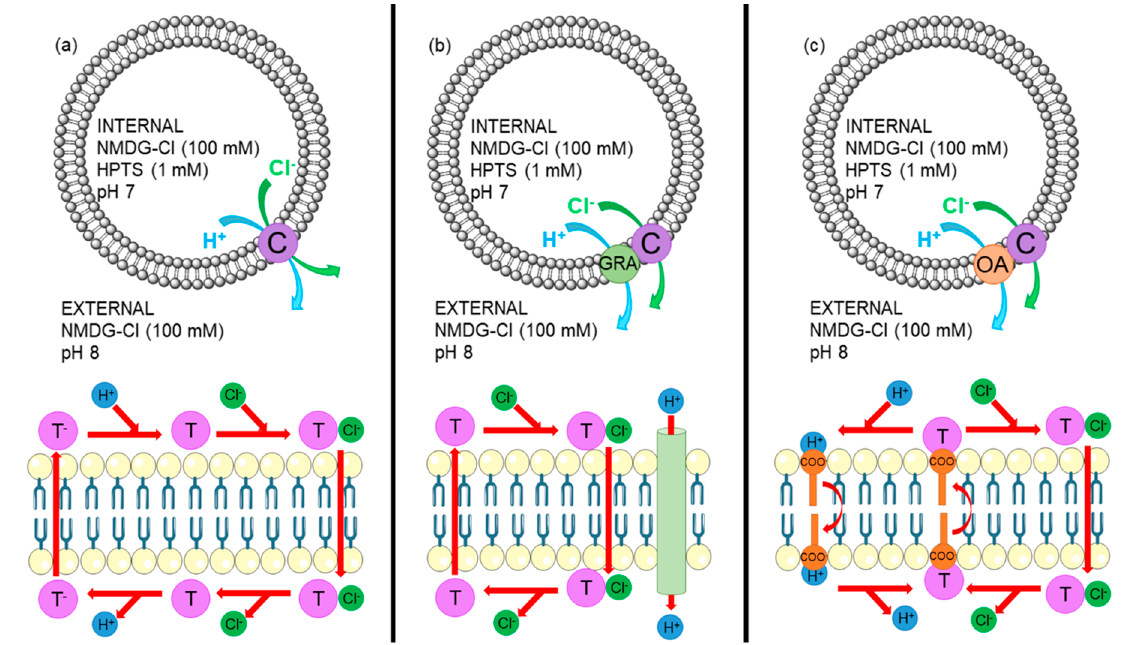
Figure 5. Top: Overview of the NMDG-Cl assay. POPC vesicles (grey) contain an internal NMDG-Cl (100 mM) and HPTS (1 mM) solution and are suspended in an external NMDG-Cl (100 mM) solution both buffered to pH 7.2 with HEPES (10 mM). HCl efflux, monitored by pH sensitive HPTS, induced by ( a ) compound (C, purple) mediated Cl − /H + symport, ( b ) gramicidin (Gra, green) facilitated electrogenic H + efflux coupled to compound (C, purple) mediated Cl − uniport, and ( b ) oleic acid (OA, orange) flip-flop facilitated H + transport coupled to compound (C, purple) mediated Cl − /H + symport. Bottom: ( a ) Compound mediated Cl − /H + symport via receptor deprotonation. The neutral receptor (T, purple) binds an anion (Cl − , green). The negatively charged complex moves across the membrane, and the anion dissociates. The receptor is deprotonated (H + , blue), and the negatively charged receptor moves across the membrane. The receptor is protonated to complete the cycle. ( b ) Compound mediated Cl − uniport. The neutral receptor (T, purple) binds an anion (Cl − , green). The negatively charged complex moves across the membrane, and the anion dissociates. Gramicidin (Gra, green) facilitates electrogenic H + efflux to balance the charge gradient build up. The neutral receptor diffuses back across the membrane to complete the cycle. ( c ) Compound mediated Cl − /H + symport coupled to fatty acid flip-flop pathway. The neutral receptor (T, purple) binds an anion (Cl − , green) and transports it through the membrane as the negatively charged complex. The anion dissociates on the exterior of the membrane. The neutral receptor binds to a negatively charged deprotonated fatty acid (COO − , orange) and moves across the membrane as the negatively charged complex. Fatty acids can translocate across the membrane when protonated (H + , blue) to complete the cycle.